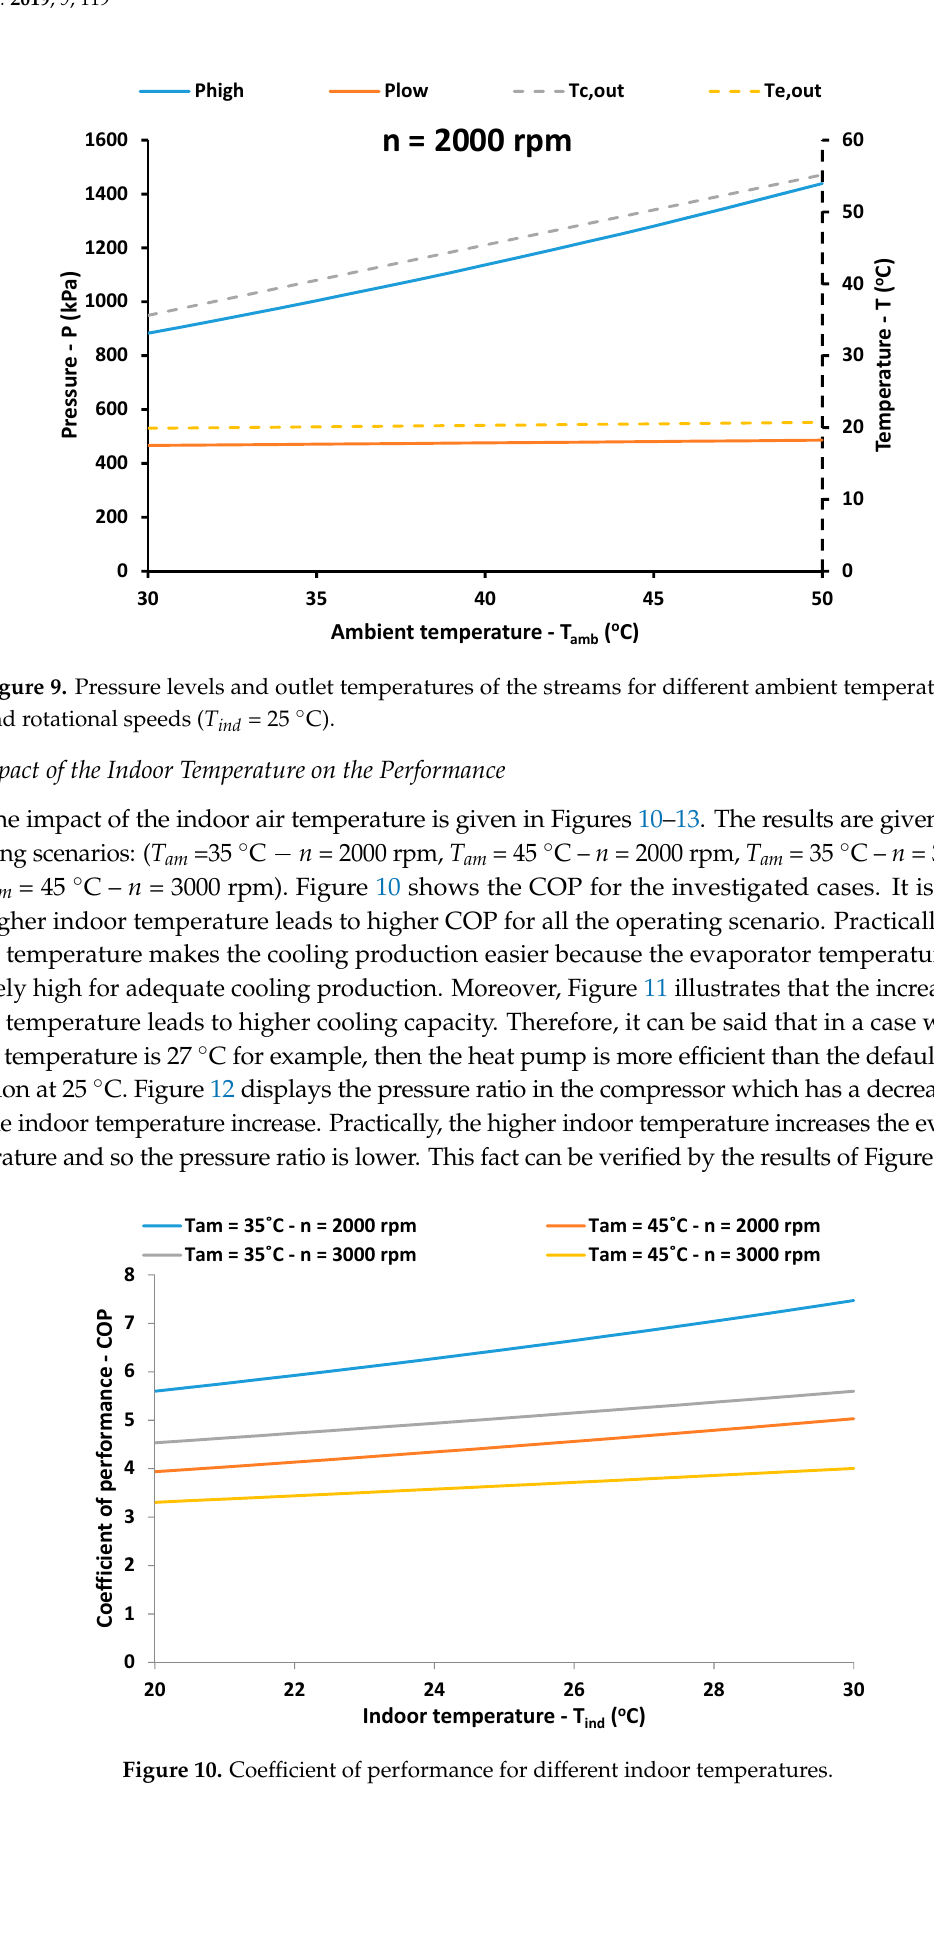
Figure 11. Cooling capacity for different indoor temperatures.